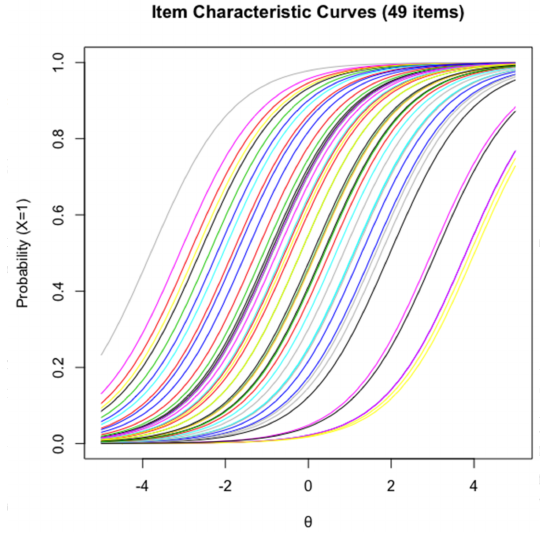
Figure 1. Item Characteristic curves for Form A and Form